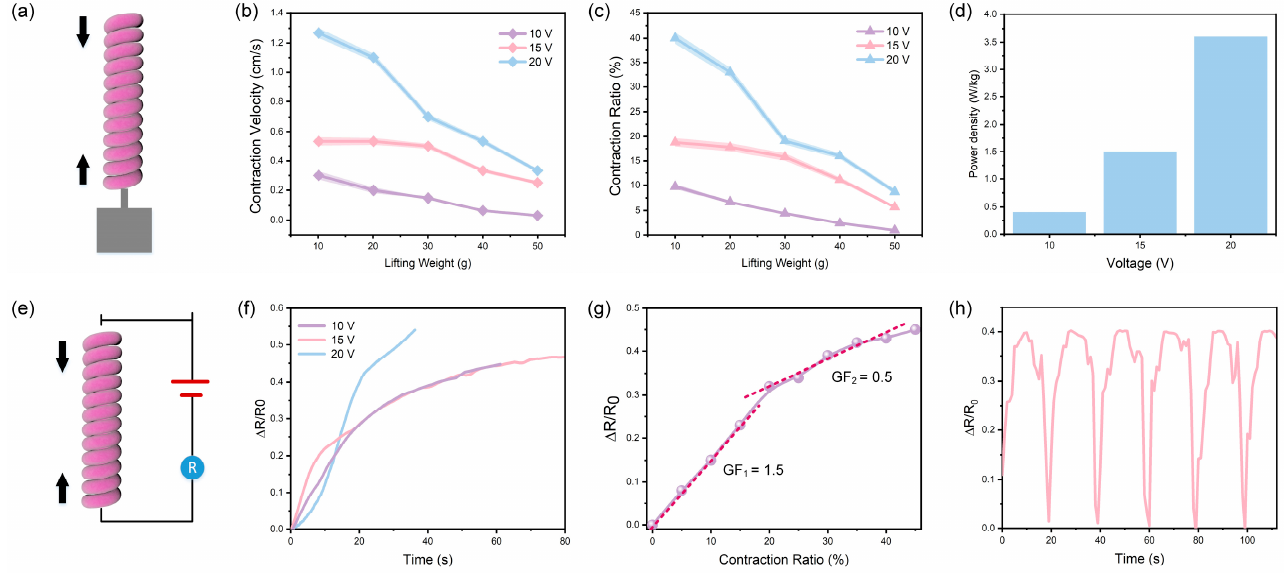
Figure 4. Actuation and in-situ actuation-monitoring properties. ( a ) Schematic illustration of the working mechanism for the actuation process; ( b ) The contraction velocity of the artificial muscle with different lifting weights under increasing voltages; ( c ) The contraction ratio of the artificial muscle with different lifting weights under increasing voltages; ( d ) The power density of the artificial muscle under increasing voltages; ( e ) Schematic illustration of the in situ actuation-monitoring process; ( f ) The resistance changes under different voltages with time; ( g ) The sensitivity of the contraction strain perception; ( h ) Resistance variation of actuation cycle tests.